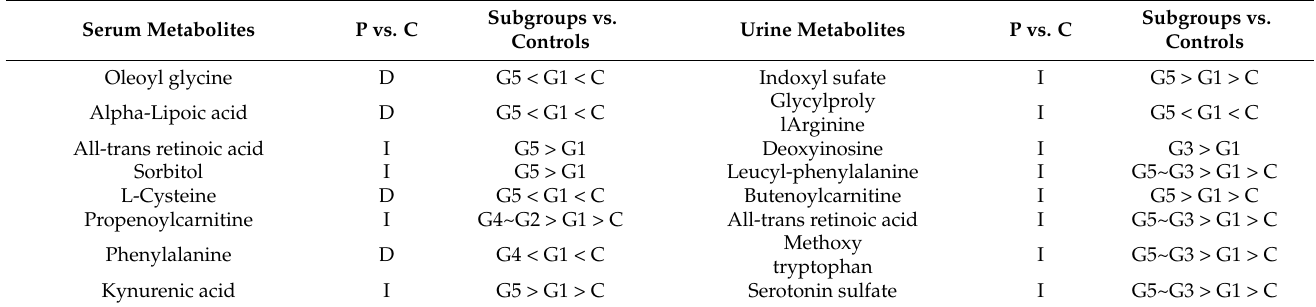
Table 4. Serum and urine metabolites selected by untargeted analysis as potential biomarkers for the discrimination between group P and group C, considering the data released from multivariate analysis (P vs. C, columns 2 and 4), as well the trends of such molecules dependent on eGFR (decreased values from G1 to G5 subgroup, respectively; columns 3 and 5). Subgroups vs. Subgroups vs. Urine Metabolites P vs. C Serum Metabolites P vs. C Controls